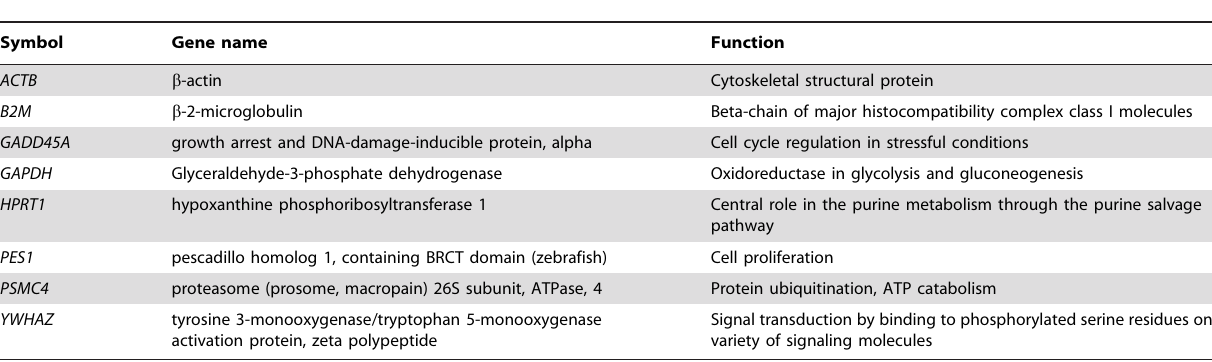
Table 1. Putative reference genes